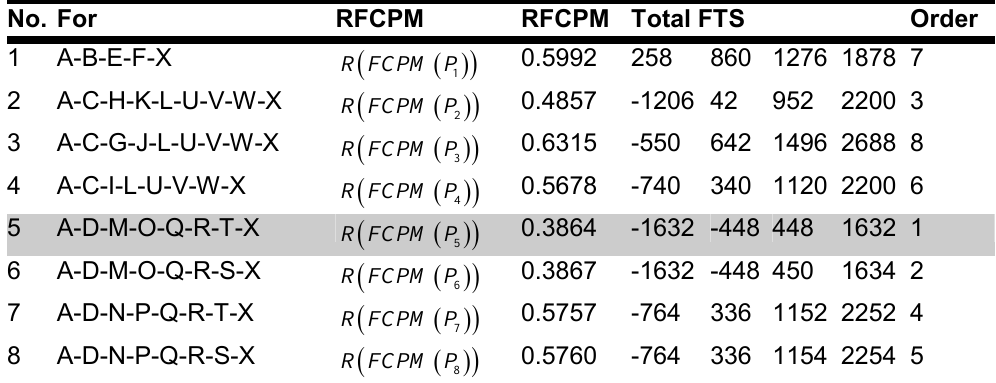
Table 2. FCPM ranking